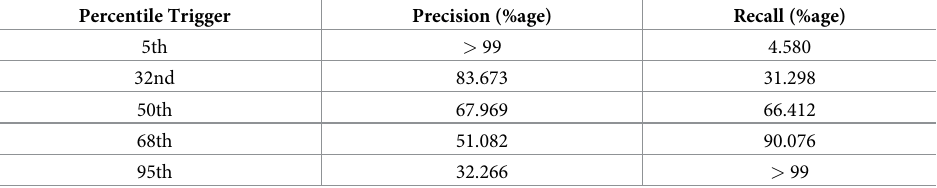
Table 1. The precision (fraction of detected epidemics are indeed epidemics) and recall (the rate at which we claim an epidemics in the case of an epidemic) as a function of the percentile (i.e. the proportion of models predicting a case rate below the threshold). For example, when we raise an alert when the 95th percentile goes above the threshold, we detect all epidemics, however, 68% of the time the claimed epidemics do not result in an epidemic; simply put we claim epidemics all the